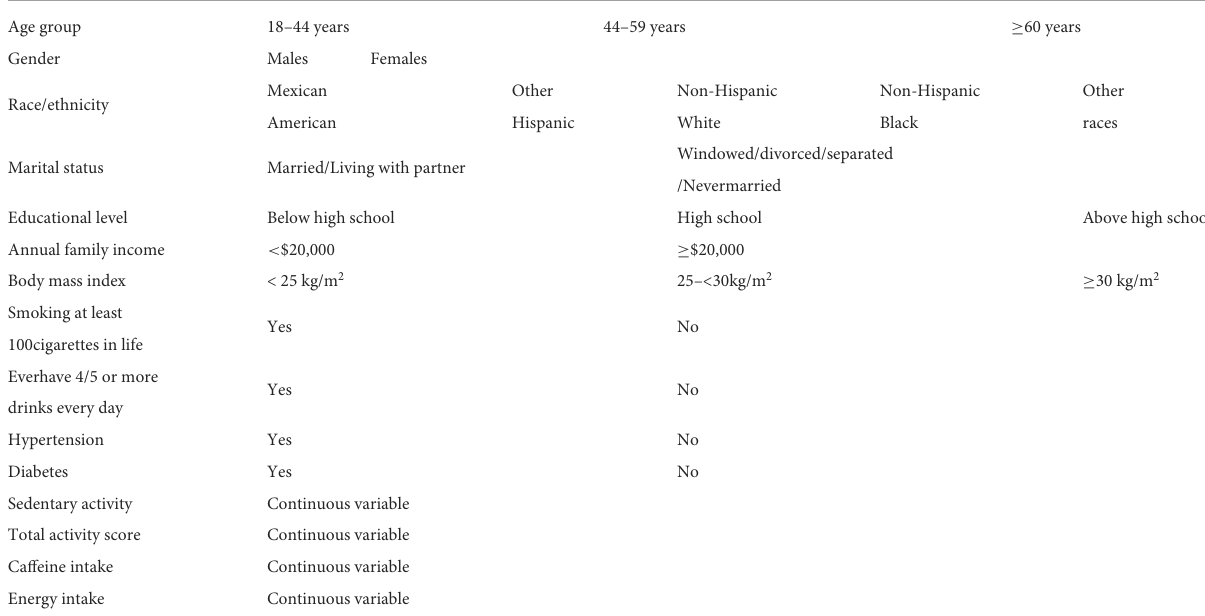
TABLE 1 Classification and types of